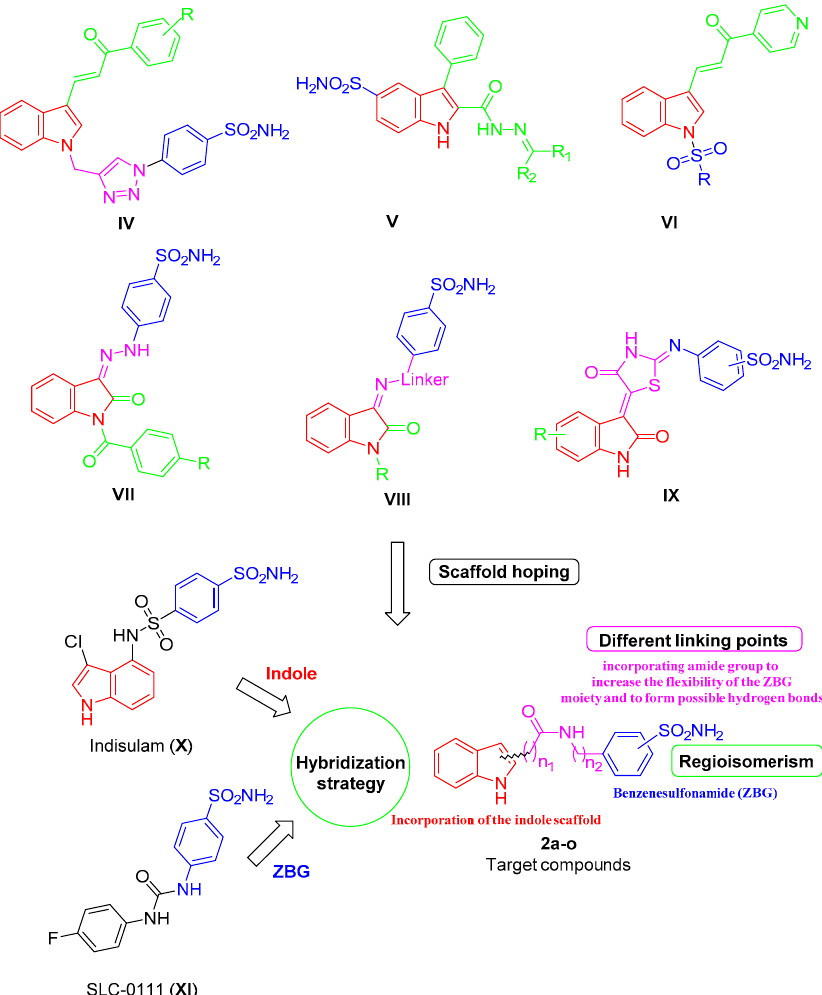
Figure 2. Design strategy of the synthesized hybrids 2a ‒ o.